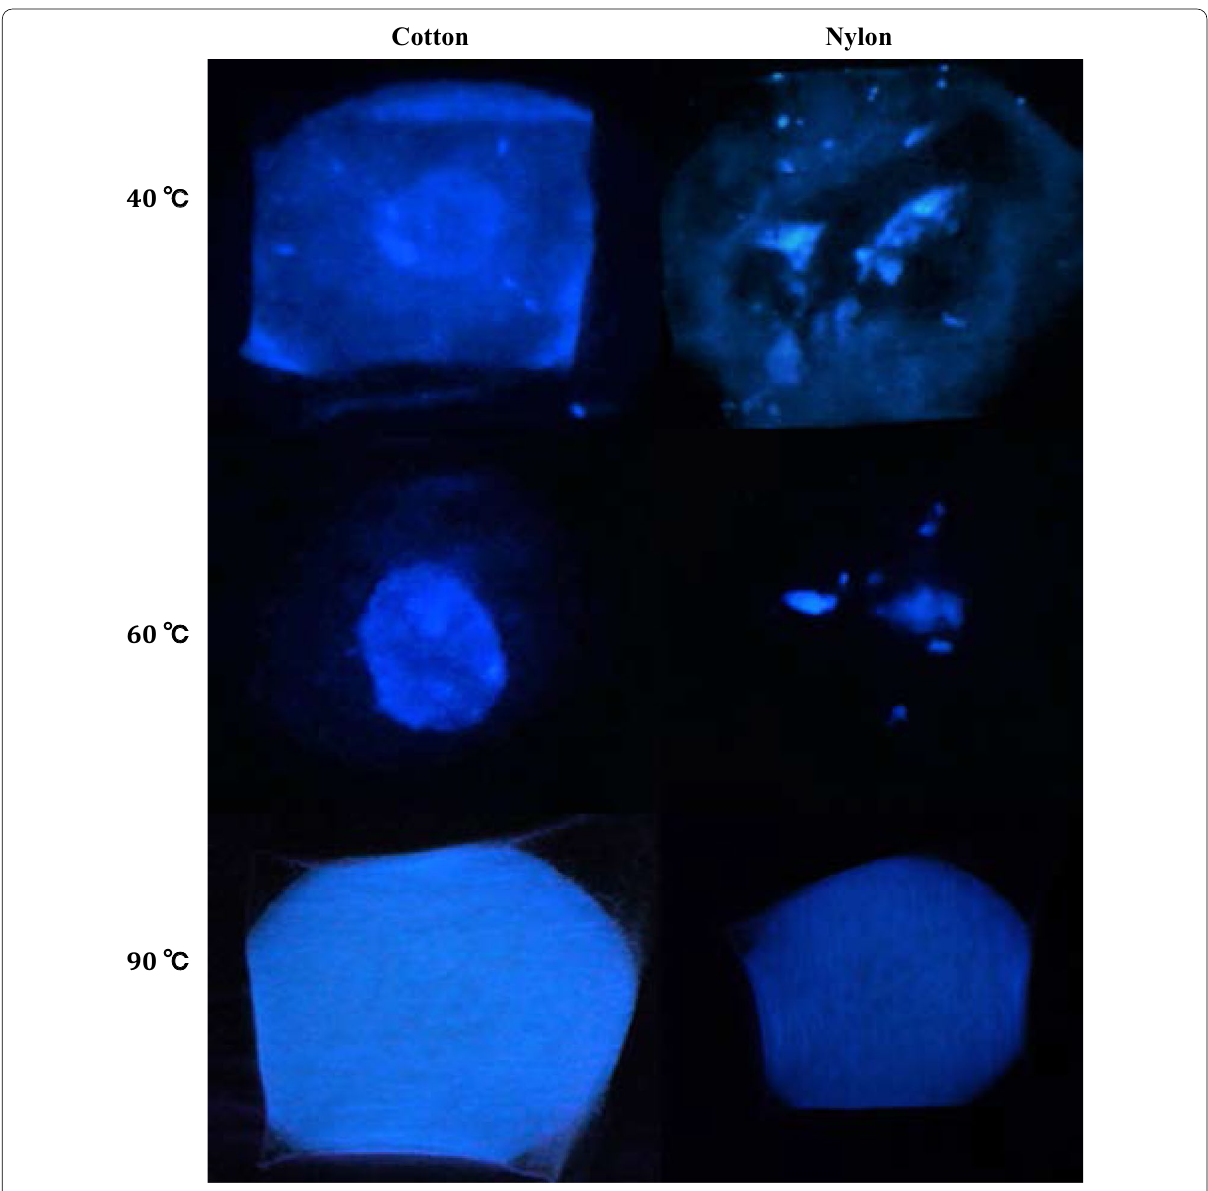
Fig. 2 Visualization of bloodstains with luminol in fabrics washed at 40, 60 and